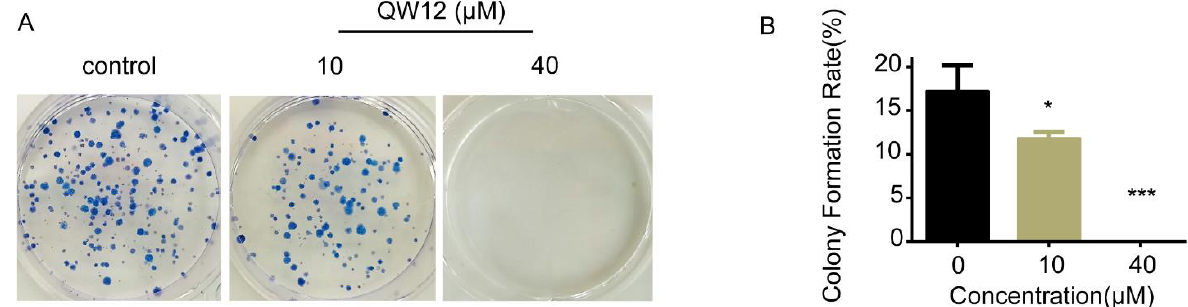
9 of 22 Figure 3. QW12 inhibited the migration of HeLa cells. ( A ) Effect of QW12 on the wound-healing of HeLa cells. ( B ) Quantitative analysis of scratch closure changes. Values are presented in means±SD